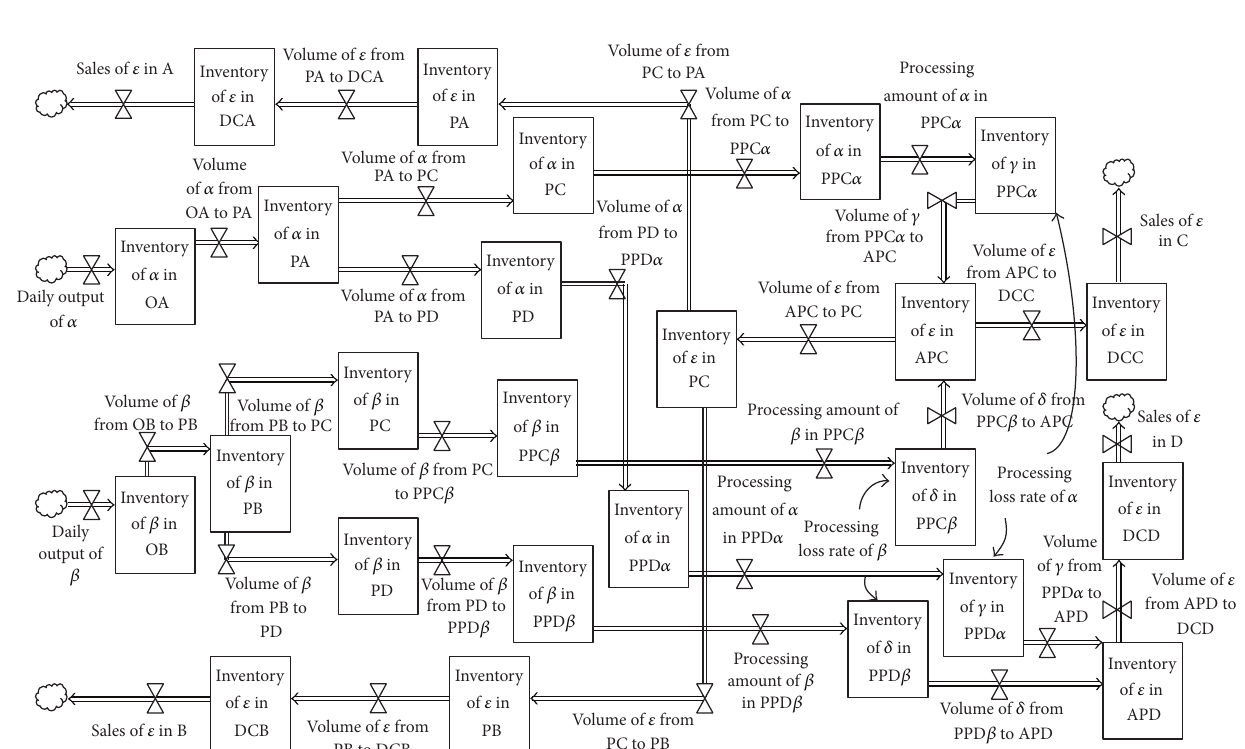
Figure 4: Flow diagram of Scheme 4